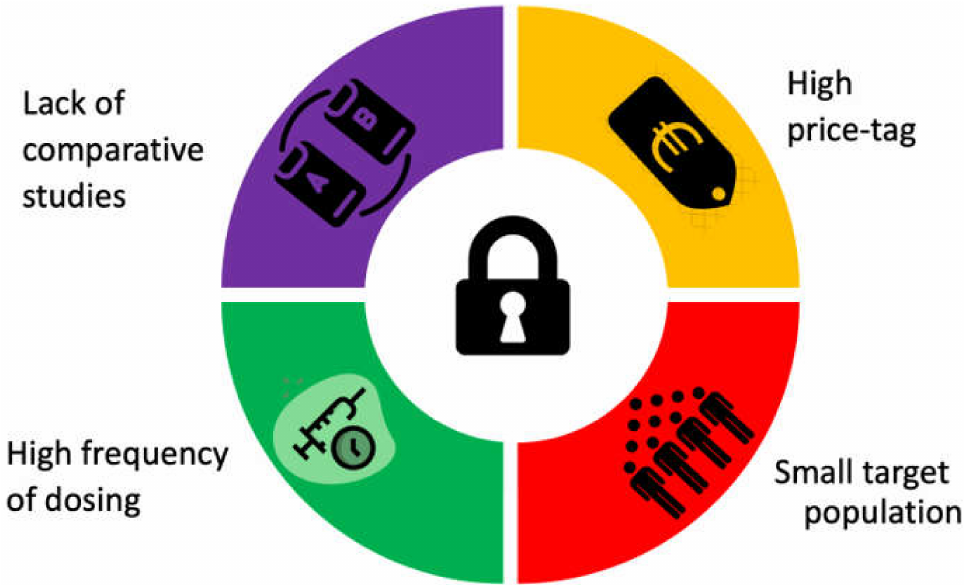
Figure 2. Challenges facing the clinical development of therapies for transthyretin amyloid cardiomy-